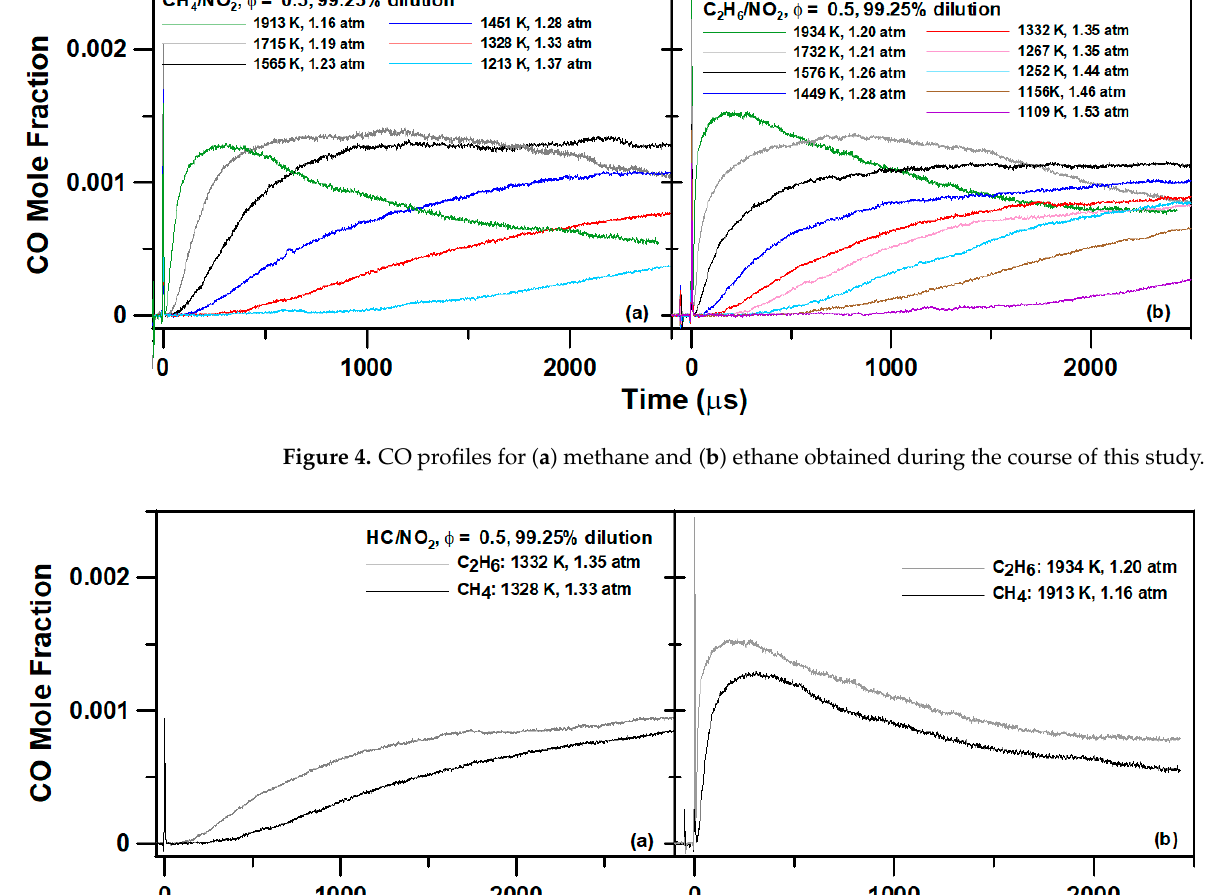
Figure 4. CO profiles for ( a ) methane and ( b ) ethane obtained during the course of this study.